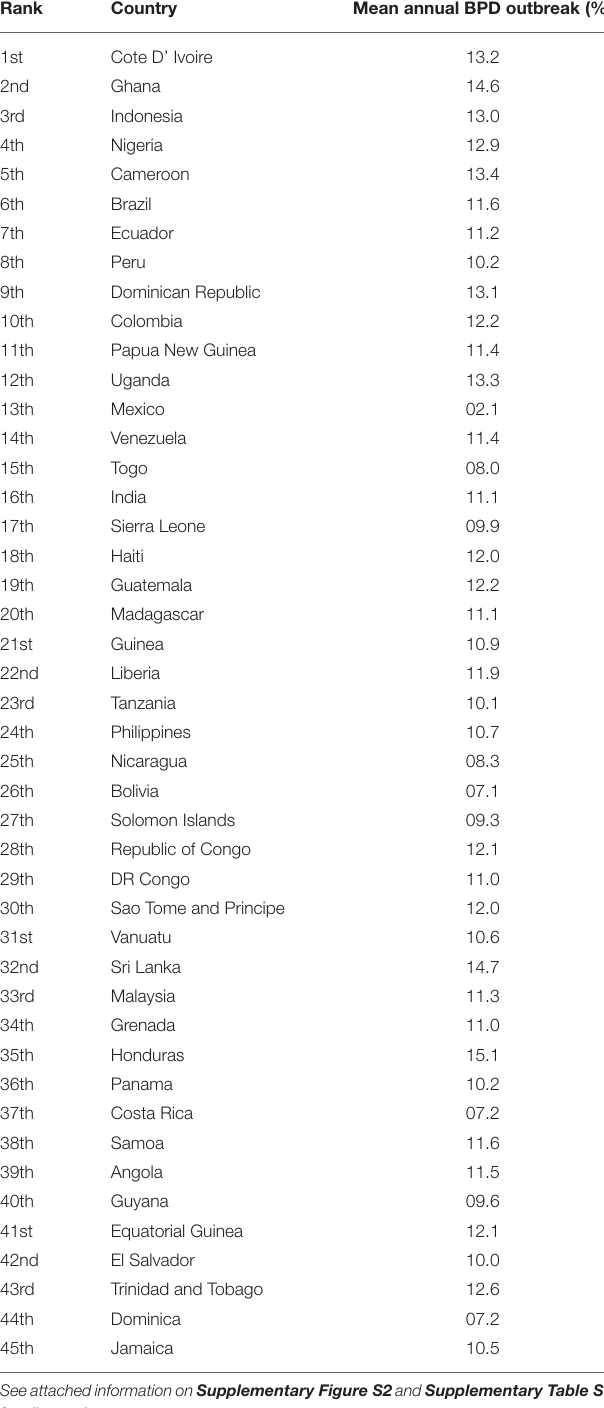
Seeattachedinformationon Supplementary Figure S2 and Supplementary Table S1 for climate data.